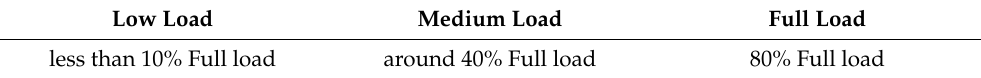
Table 4. Load data set.